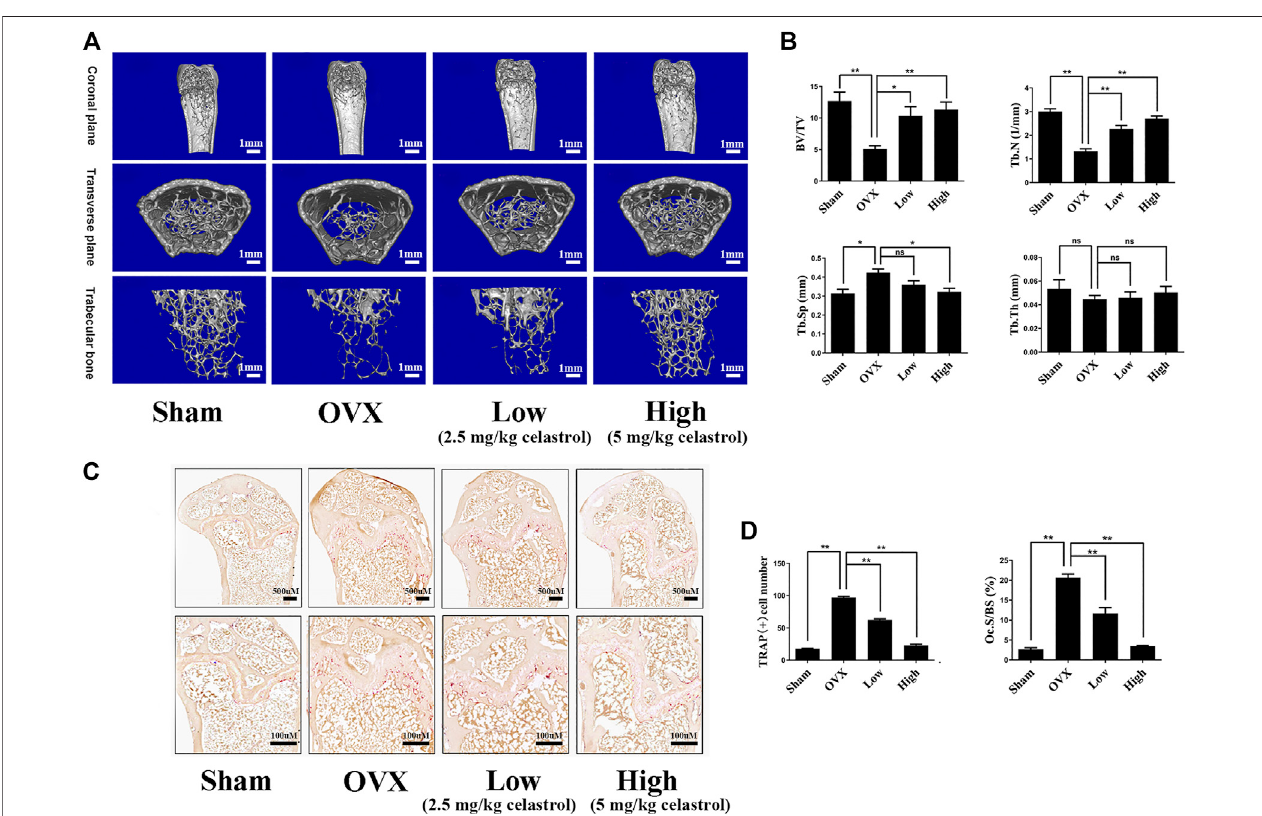
FIGURE6| Celastrolpreventedbone lossinovariectomizedmice invivo . (A) Three-dimensional reconstruction micro-CTpicturesofthefemurmicro-architecture. (B) Quantitativemicro-CT examination ofeach sample ’ s bone volume totissue volume (BV/TV), trabecular number (Tb.N), trabecular separation (Tb.Sp),and trabecular thickness(Tb.Th). (C) RepresentativeimagesofTRAP-stainedfemurs. (D) CountingthenumberofTRAP-positivecellsandtheOcs/BS.Allexperimentswerecarriedout three times, and all data are showed as the means ± SD; * p < 0.05, ** p <